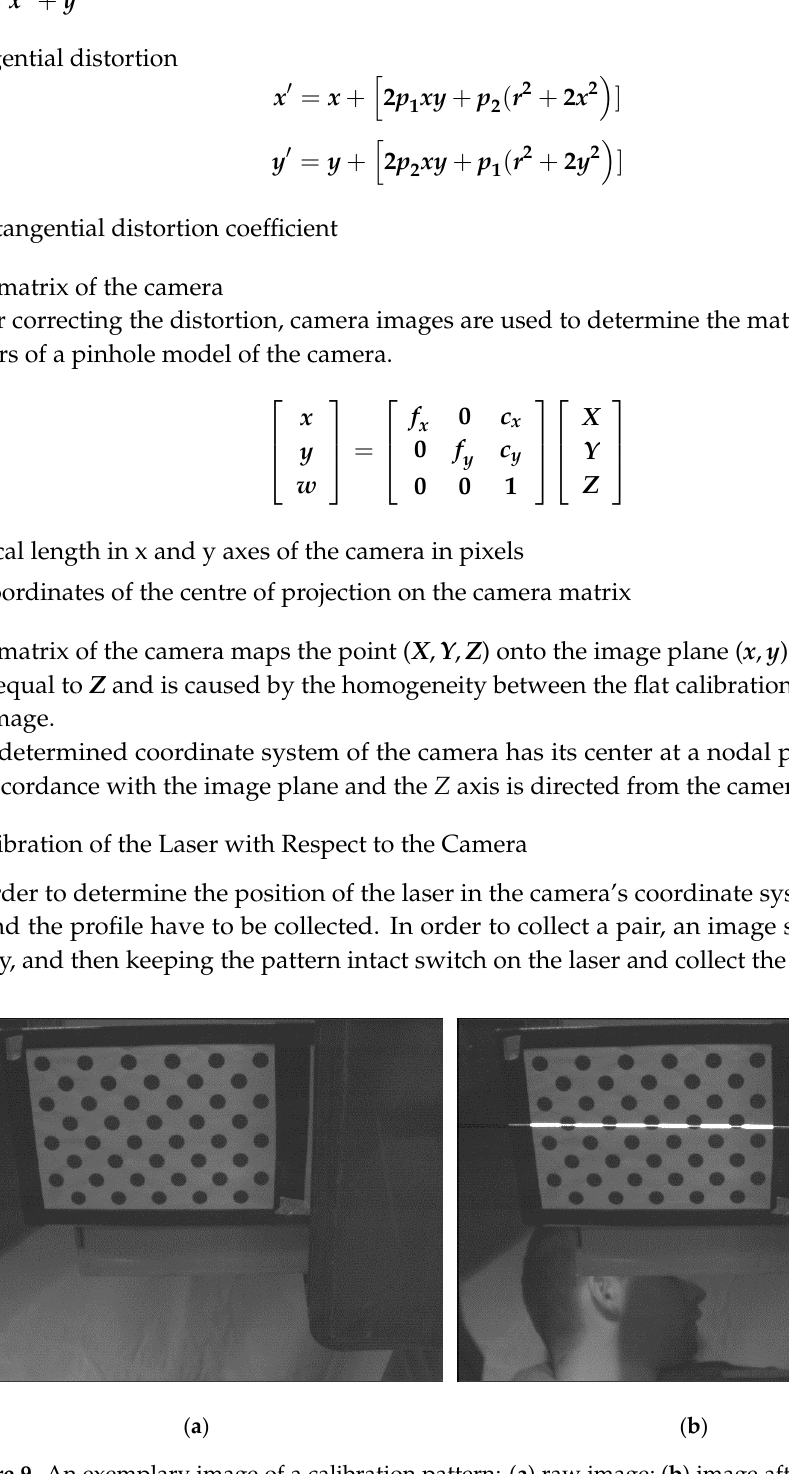
Figure 9. An exemplary image of a calibration pattern: ( a ) raw image; ( b ) image after switching on the laser. the